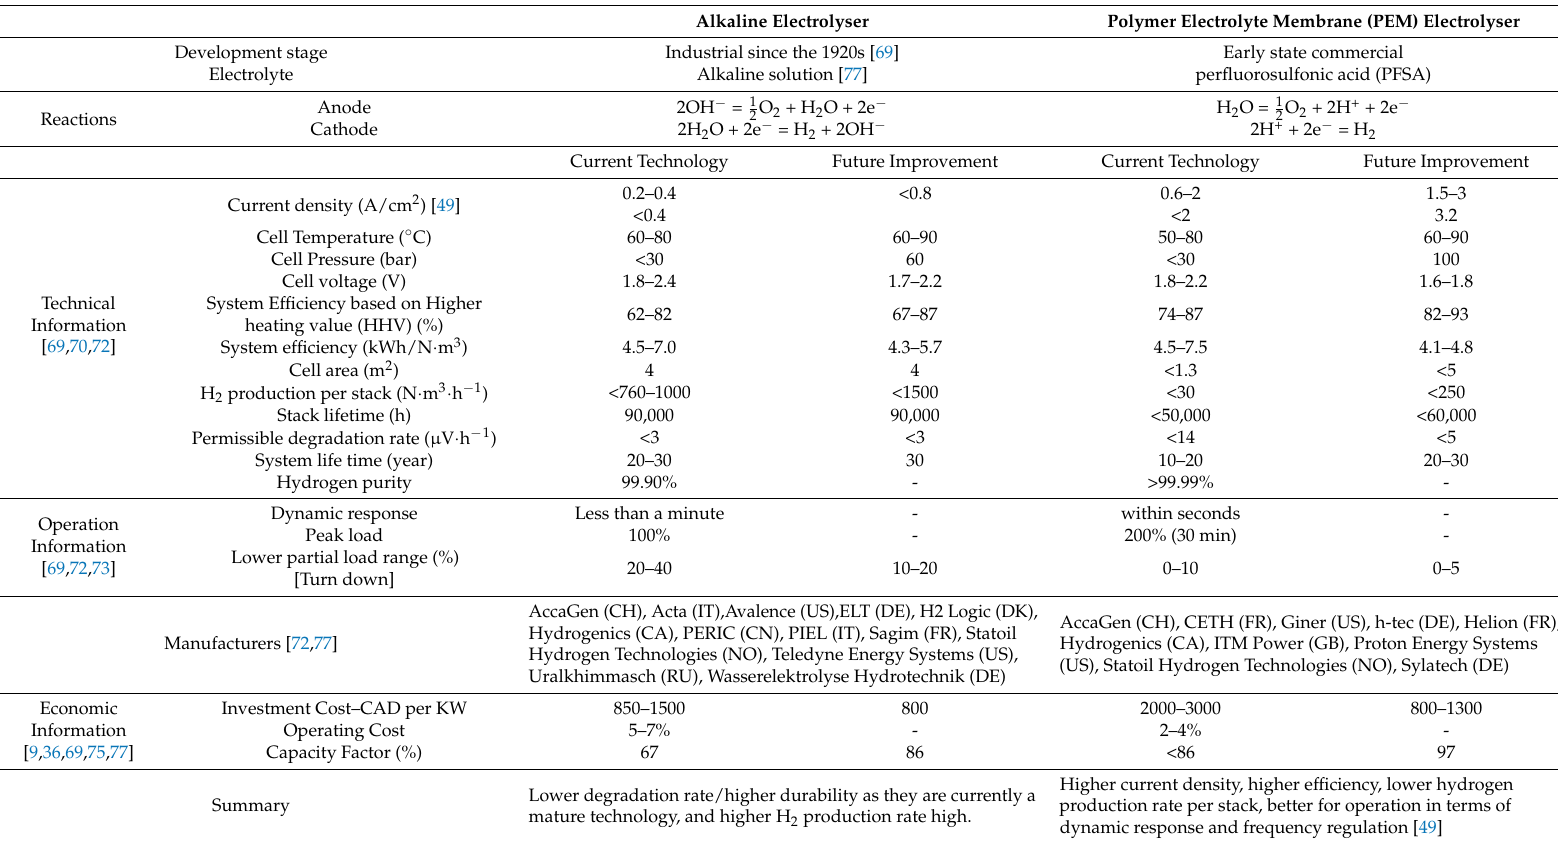
Table 1. Alkaline and Polymer Electrolyte Membrane (PEM) electrolyser technical, operational, and economic data. Alkaline Electrolyser Polymer Electrolyte Membrane (PEM)